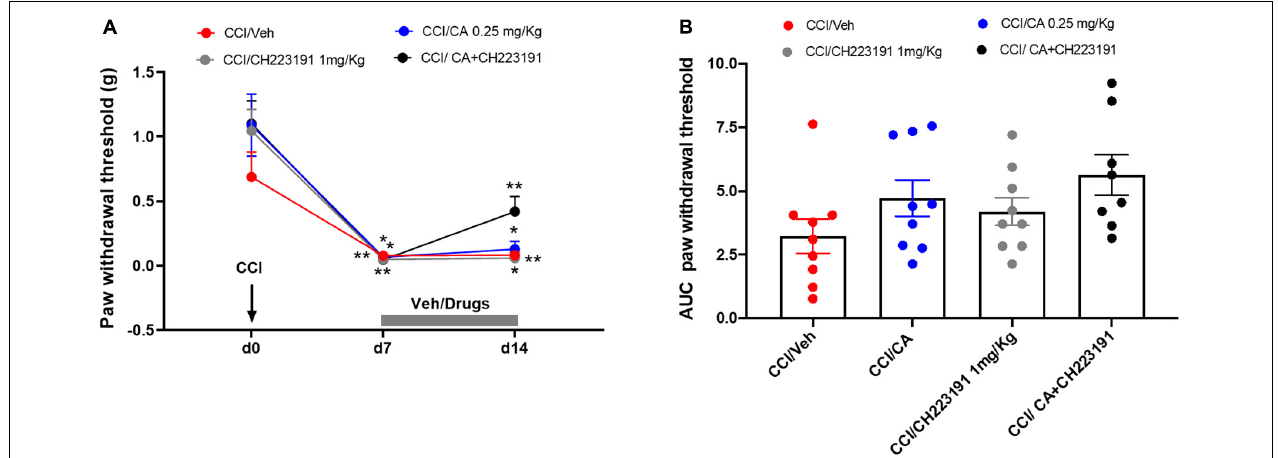
FIGURE 6 | Analgesic activity of chronic treatment with CA was disclosed when the drug was combined with systemic CH223191 in WT CCI mice. (A) Effect of repeated administrations of cinnabarinic acid (0.25 mg/Kg) alone or in combination with CH223191 (1 mg/Kg) on paw withdrawal threshold (g) in CCI mice ( n = 7–9 mice per group). Black arrow indicates chronic constriction surgery (d0). Grey bar indicate the duration of drug treatment (from d7 to d14). (B) The area under curve (AUC) analysis (normalized to -1 d values) of paw withdrawal thresholds in CCI mice treated with vehicle, CA, CH223191 or CA+CH223291 ( n = 7–9 mice per group). Two-way ANOVA for repeated measures followed by Sidak post-hoc test was used for comparison between pre-drug and post-drug values. * p < 0.05 and ** p < 0.01 indicate statistically significant difference vs. baseline (d0).